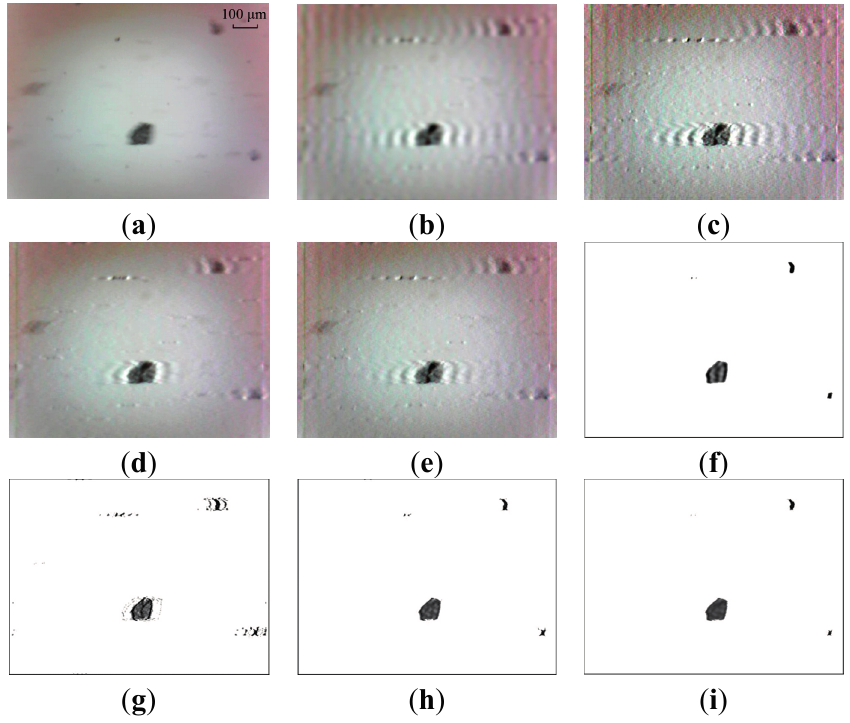
Figure 15. Test results—image 1: ( a ) input image; ( b – e ) restored images by LS, BD, LR and WF based on the whole image, respectively; and ( f – i ) output images by LS, BD, LR and WF based on local blurred regions, respectively.